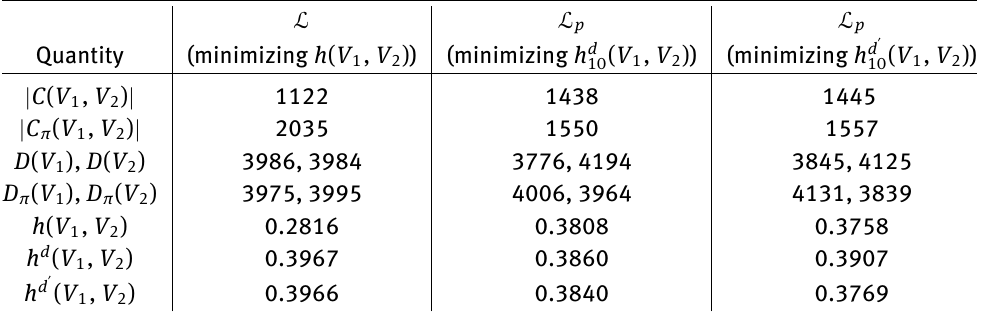
Table 3: Results of spectral bisection using the second eigenvectors of L and L p to find low values for h ( V 1 , V 2 ) , h d ( V 1 , V 2 ) , ′ ( and h d V 1 , V 2 ) , for a randomly generated graph of 1000 vertices. The partitions V 1 , V 2 are obtained using the method de- scribed in Sections 2 and